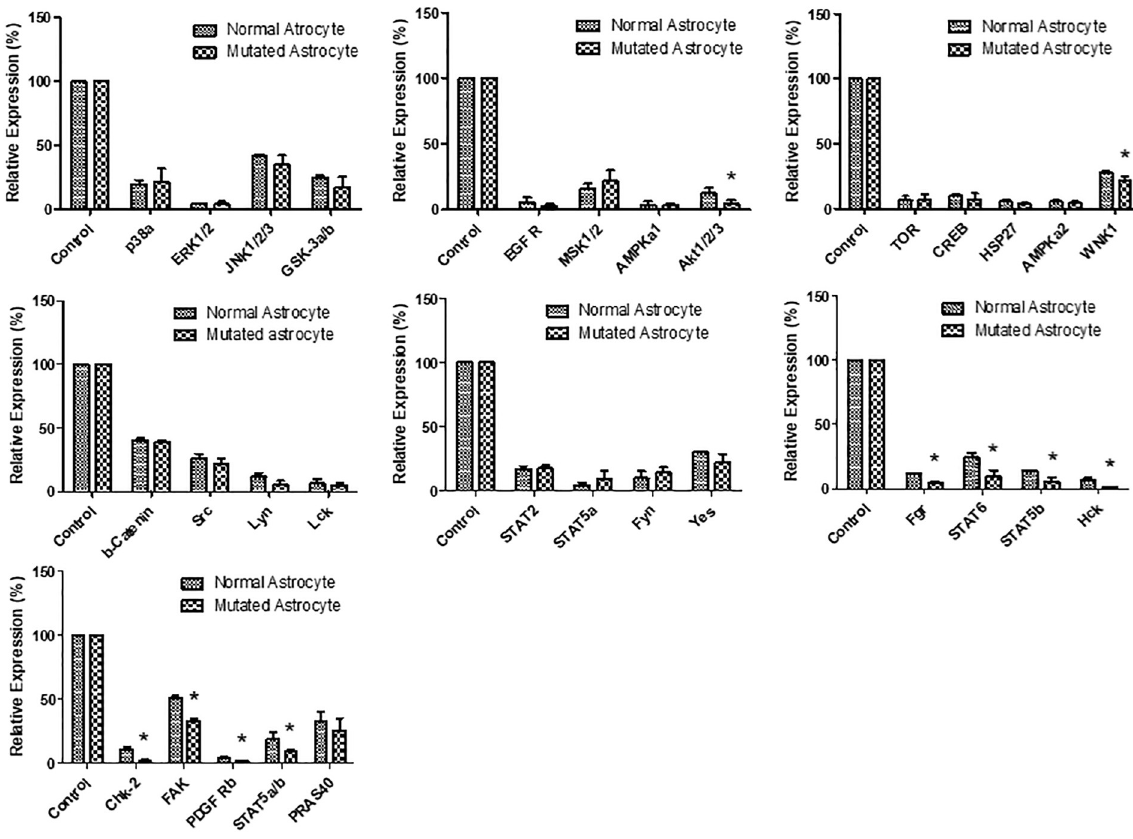
Fig 4. Normalised phospho-kinase expression of mutant astrocytes compared to a normal control. An asterisk ( � ) is displayed when the p- value was less than or equal to 0.05; N = 2.